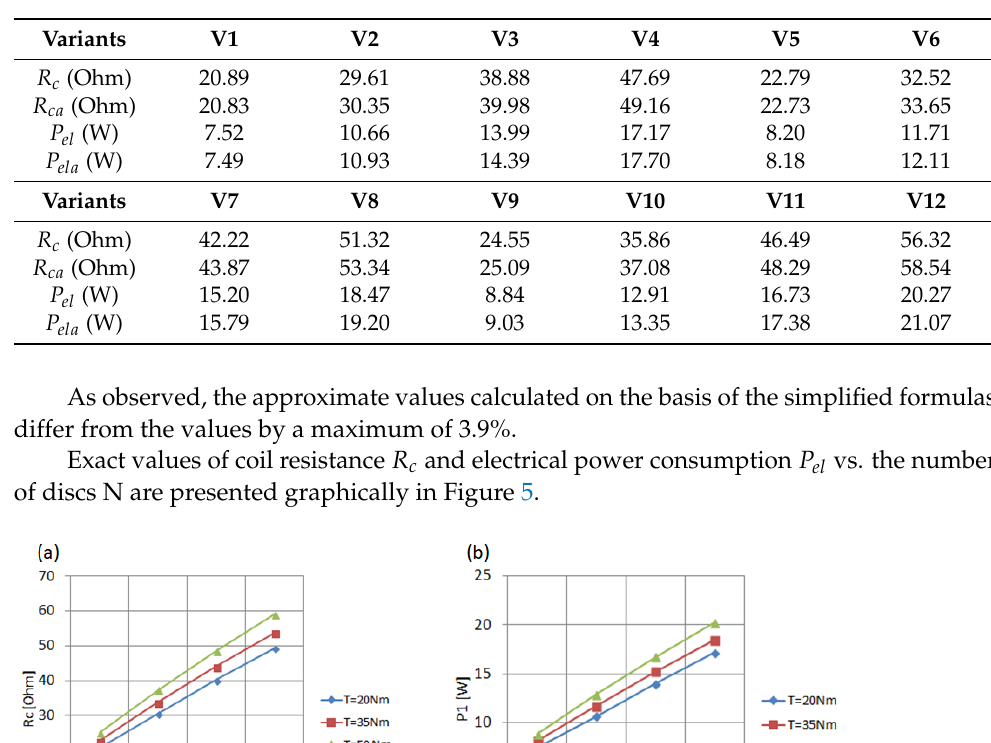
Table 2. Coil resistances and electrical power consumption for variants V1–V12 (exact values: R c , P el and approximate values determined on the basis of simplified formulas ( R ca and P ela )).